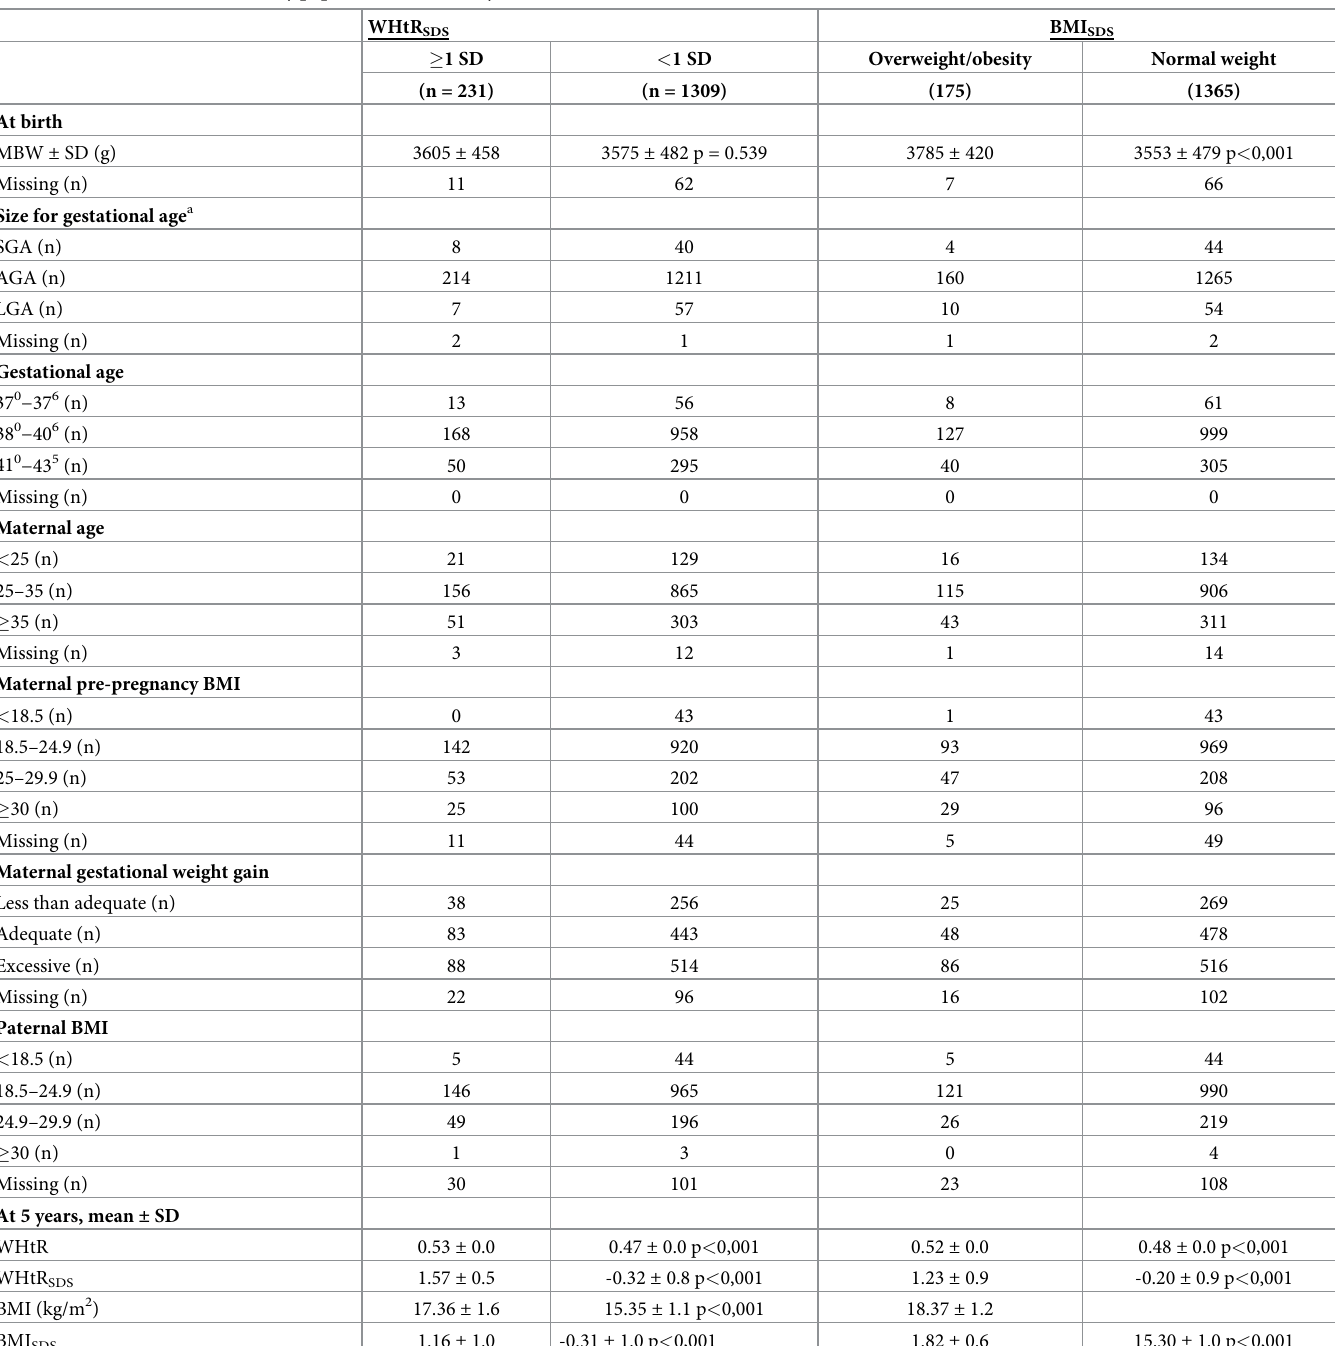
Table 1. Characteristics of the study population classified by WHtR SDS and BMI SDS